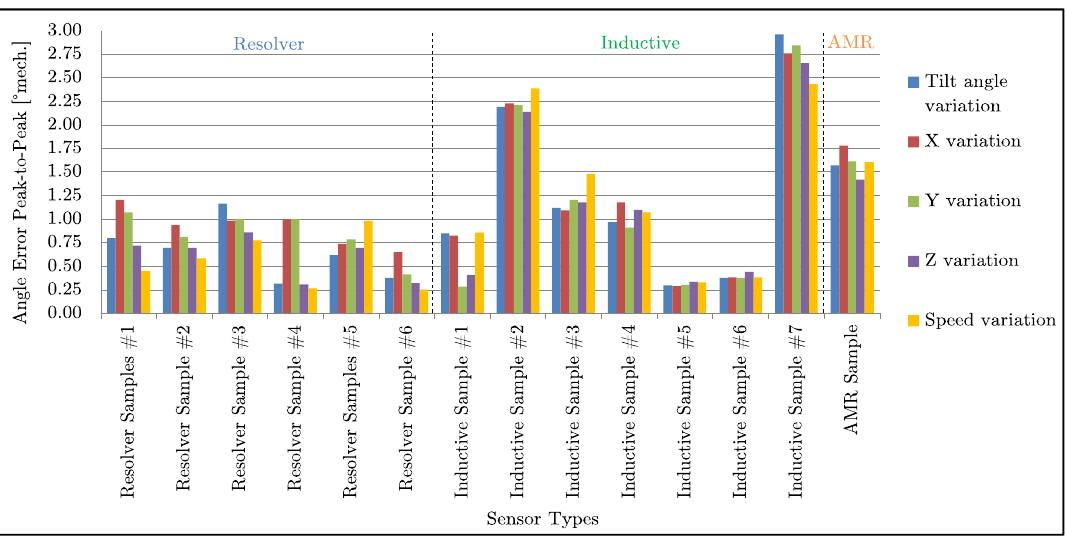
Figure 17. Benchmark of both mechanical and rotor speed parameter variations at RT = 25°, by use of the average angular peak-to-peak error from each test case, which is one parameter variation.